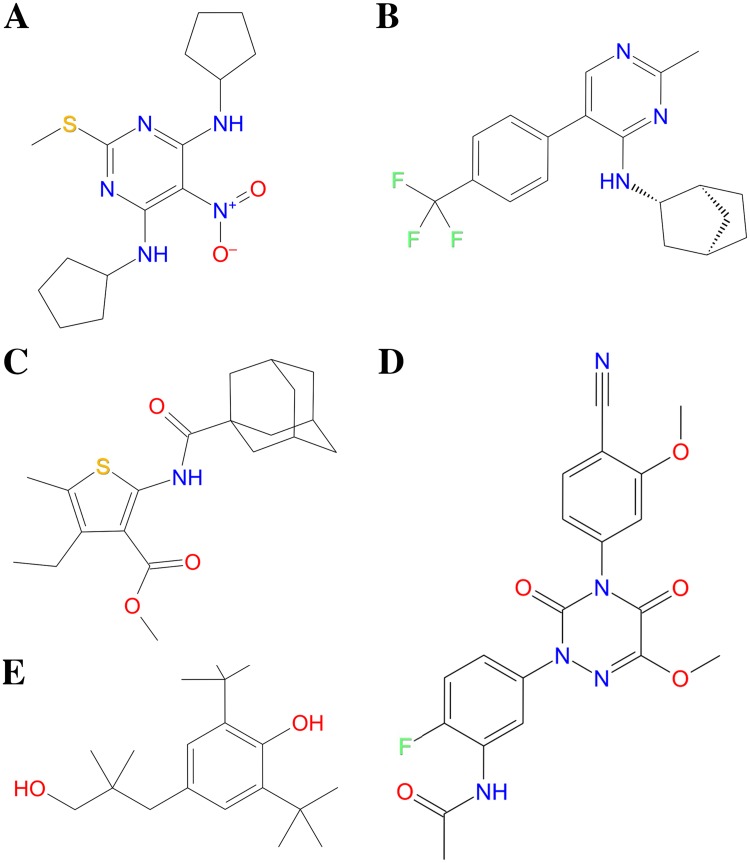
Structures of PAM cluster 1–5 representatives.(A) GS39783 (Cluster 1), (B) 27 (BHF177) (Cluster 2), (C) COR627 (Cluster 3), (D) ADX71943 (Cluster 4), and (E) rac-BHFF (Cluster 5). Cluster 1 Emax range: 20%–78% (11 PAMs), cluster 2 EC50 range: 870–5000 nM (10 PAMs), cluster 3 range of increase (%) compared to 10μM [GABA]: 5.9%–19% (13 PAMs), cluster 4 EC50 range: <100–1000 nM (32 PAMs), and cluster 5 EC50 range: 4.6–4600 nM (6 PAMs). Please see S1 Table for full activity data.